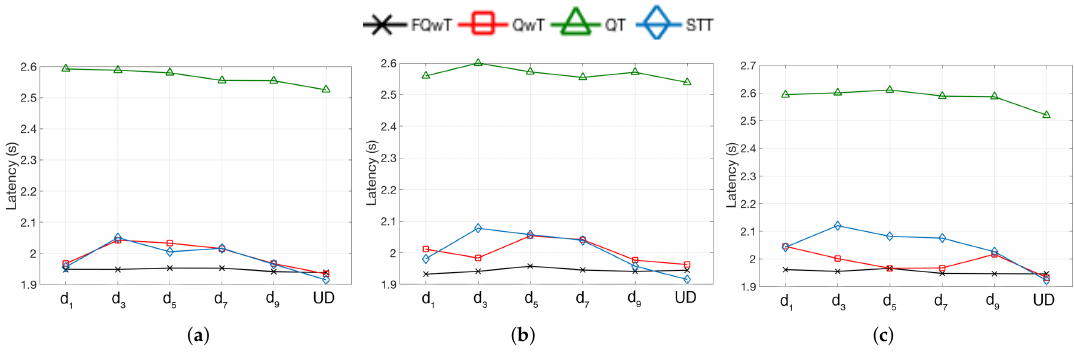
Figure 14. Simulation results obtained for the latency for different tag subdistributions, when FPL is 20, 60 and 100, and d m varies from d 1 to UD. ( a ) FPL = 20; ( b ) FPL = 60; ( c ) FPL =